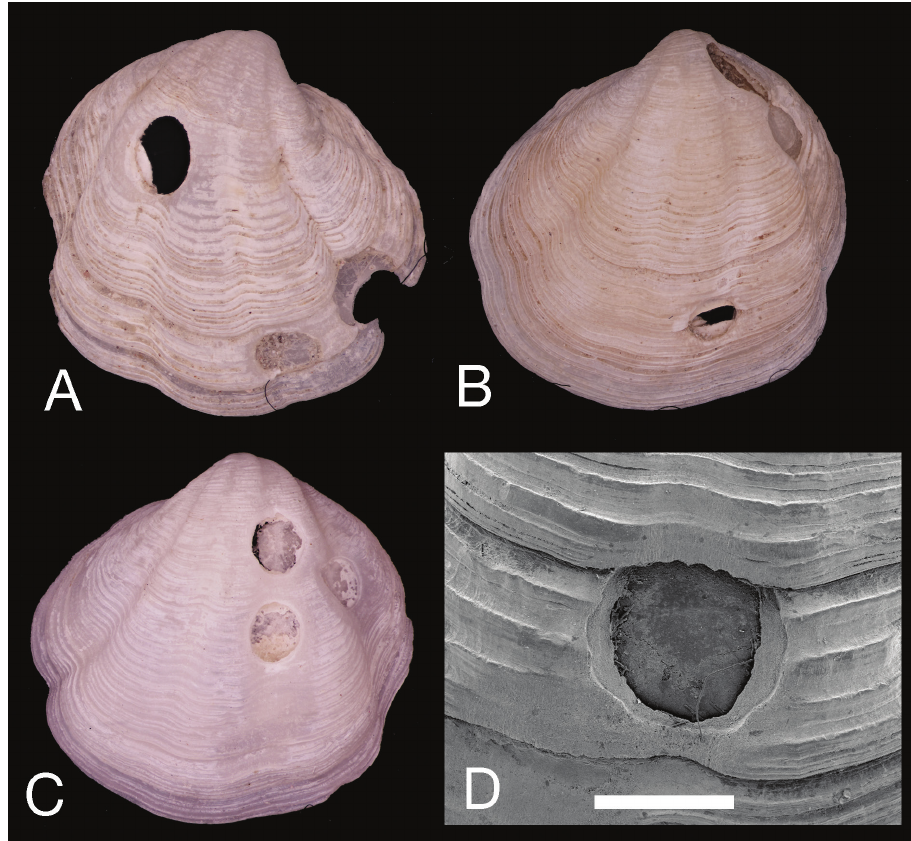
Figure 5. Failed and multiple drill holes in shells of Pleurolucina harperae . A L = 6.8 mm B L = 9.8 mm C L =7.8 mm D SEM of failed drill hole terminating at conchiolin layer. Scale bar = 1.0